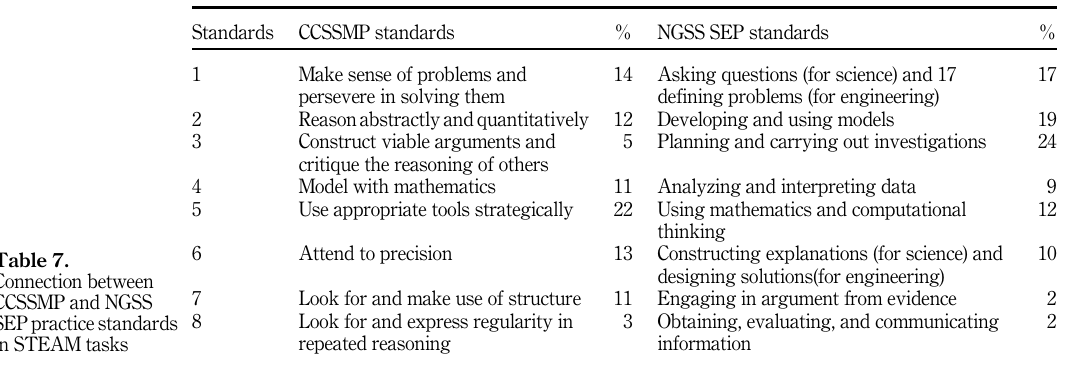
Table 6. Connection between NGSS, ETS and CCSSM standards in the STEAM